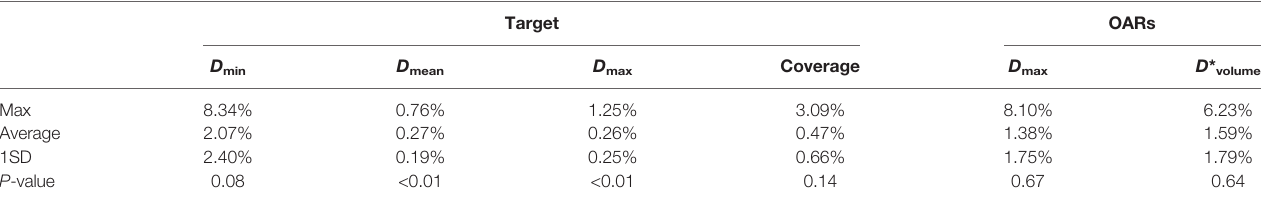
TABLE 5 | The dosimetric difference for the target and all OARs a